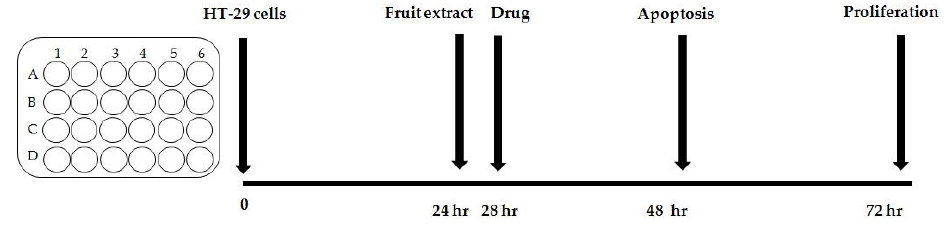
Figure 1. Scheme of the experiment.